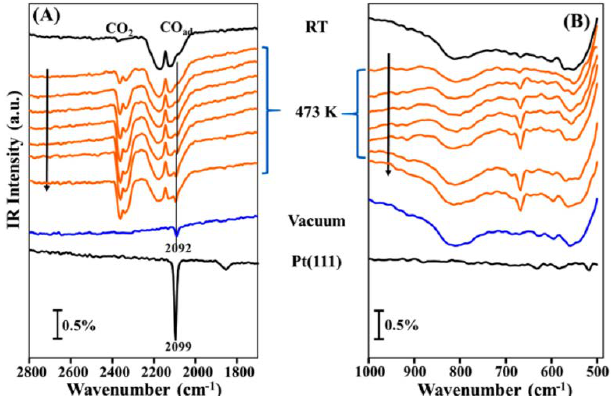
Figure 1. ( A and B ) In situ IRAS spectra for CO oxidation on the 1 ML (TiO x -Re) film at 473 K. Reprinted with permission from Reference [32]. Copyright 2018, American Chemical